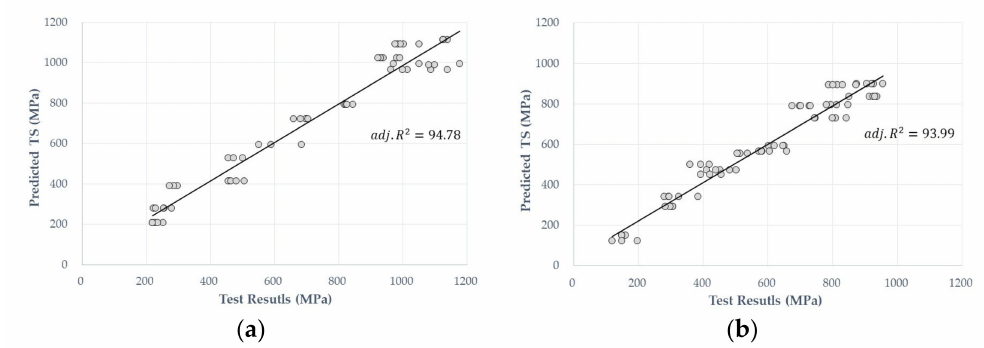
Figure 4. Relationship between the predictive and test values from the PRA results for the ( a ) BFRP and ( b ) GFRP predictive models.